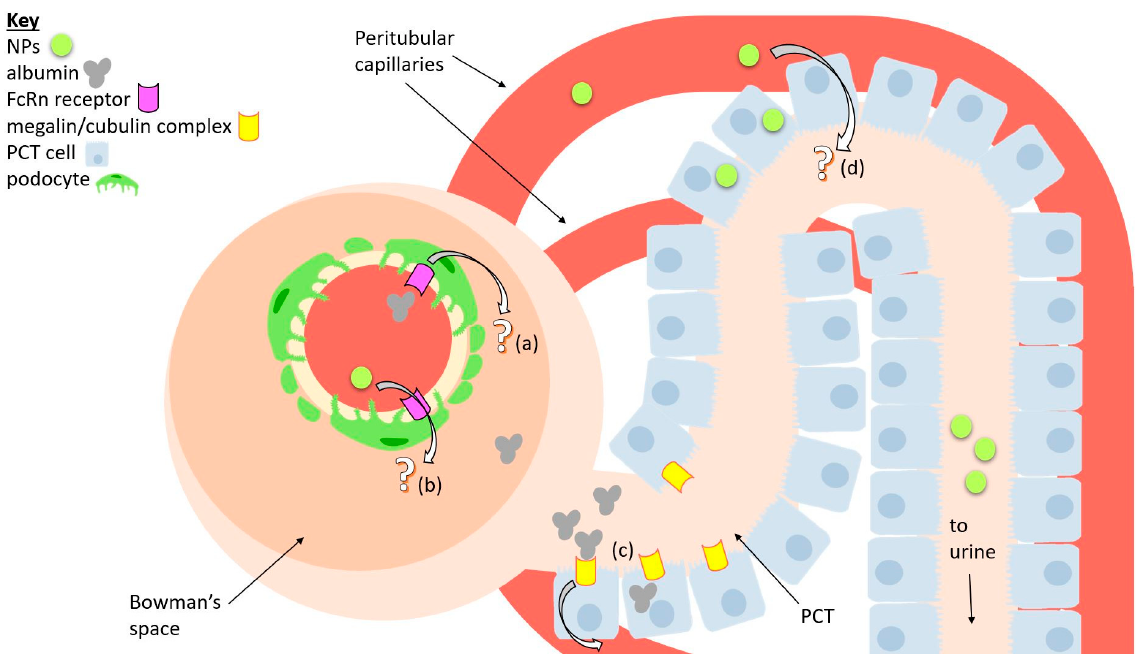
Figure 3. A diagram of a simplified nephron that summarizes possible mechanisms of transport for nanoparticles (NPs) and albumin. ( a ) A possible way albumin may be transcytosed from glomerular capillaries into tubules is through the FcRn receptor, which is expressed by podocytes. ( b ) Similarly, NPs may perhaps take the same route. ( c ) Reabsorption of albumin back into the bloodstream through interactions with the megalin/cubulin receptor complex, expressed by proximal convoluted tubule (PCT) cells. ( d ) A possible pathway for NPs being transcytosed via PCT cells is possibly also due to large absorptive pressure.